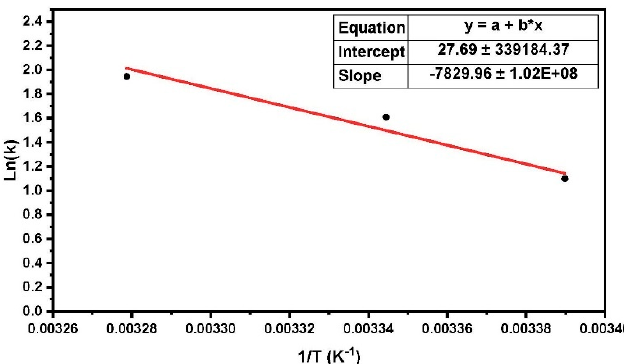
Figure 6. Arrhenius plot of the strain burst in HDPE with 45.3% crystallinity. The value of the activation energy obtained at different temperatures was 0.64 eV (in the figure, multiplication denote by an asterisk *).